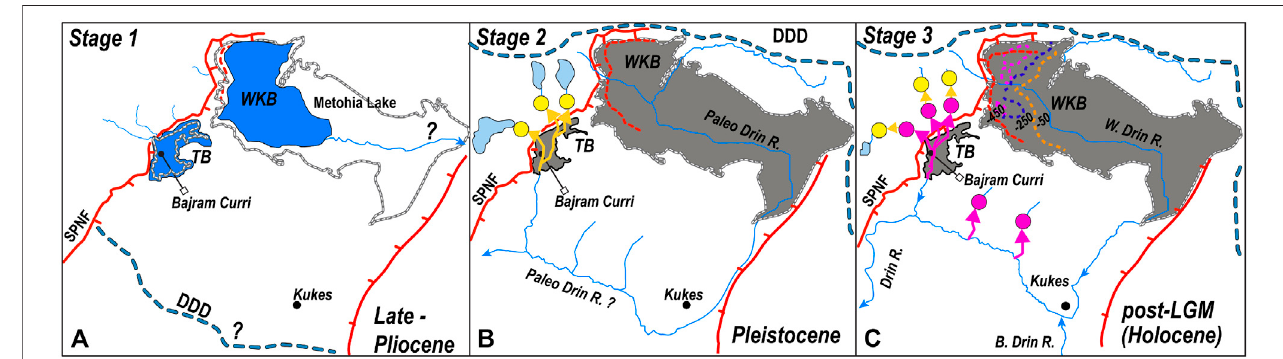
FIGURE11| Post-MioceneevolutionofdrainageinthevicinityoftheTropojaBasin(TB)andWesternKosovoBasin(WKB)attheDinaric-Hellenicjunction.Sketches arenottoscale: (A) Stage1(LatePliocene): theTBand WKBaretwointernallydrainedintramontanelakes; (B) Stage2(Pleistocene): Firstriverintegration andtransition from internally drained (endorheic) to externally drained (exorheic) basins. Upstream migration of fi rst generation knickpoints at the outlet of the TB to the Paleo-Drin (yellow arrows); (C) Stage 3 (Post-LGM, Holocene): Incision of the Drin River due to dramatically increased erosional capacity through downstream river capture (seetextfordetails).KnickpointspropagateupstreamfromthetrunkintothetributarybasinsinthefootwalloftheSPNF.Firstgeneration(yellowdots)migratesupstream from the trunk (Drin) after the second integration event. Symbols: Blue lines - river network, thick grey lines and grey polygons - present-day extent of the TB and WKB, thick red lines - normal faults of the SPNF system, light blue polygons - cirque glaciers in the Albanian Alps of northern Albania, pink arrows – migration of second generationofknickpoints.Dottedcoloredlinesinstage3oftheWKBrepresentpresent-dayisopachsofthebaseofMiocene-Pliocenesediments(basedontheTectonic Map of Kosovo, 1:200,000, Zeka,